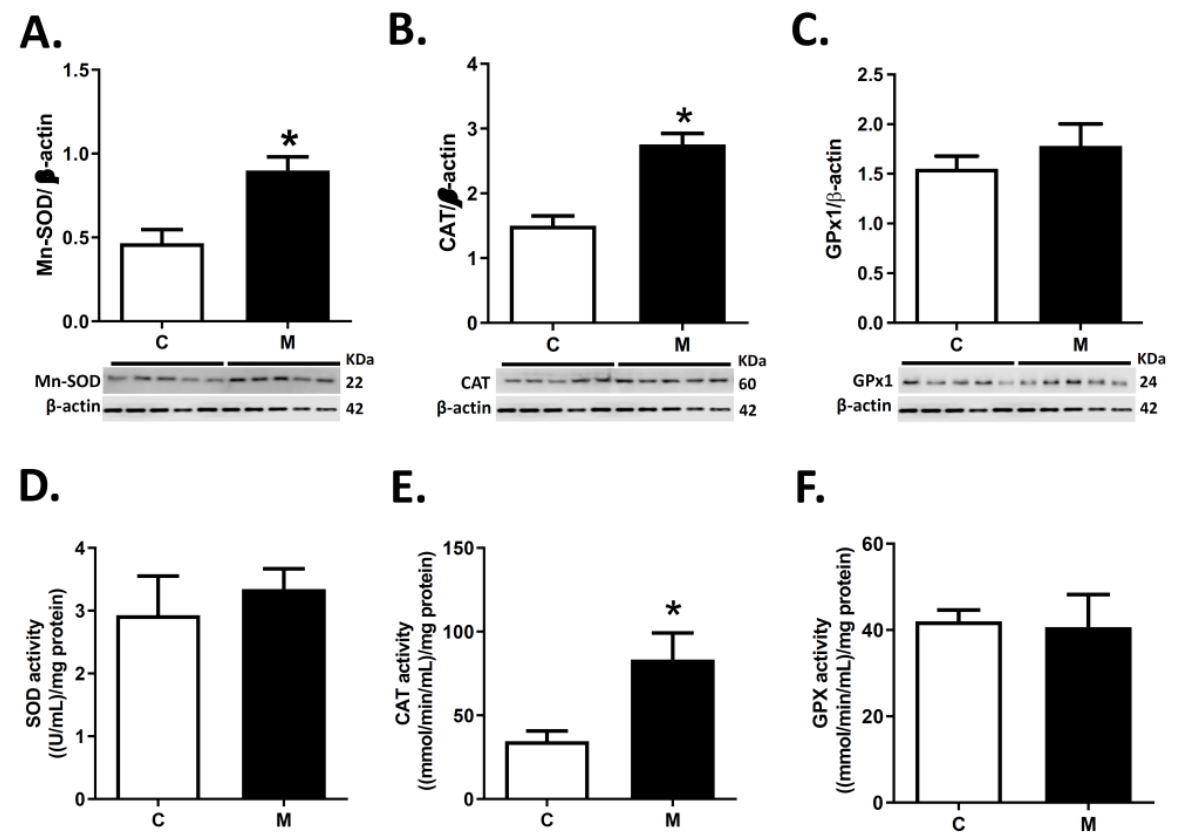
Figure 3. Enzymatic antioxidant expression and activity in right ventricle. Superoxide dismutase (SOD, ( A )), Catalase (CAT, ( B )) and Glutathione peroxidase (GPX, ( C )) expression; and SOD ( D ), CAT ( E ) and GPX ( F ) activities, in right ventricle at 29 days old. Groups are control (C, white bars) and melatonin treated (M, black bars) lambs. Data expressed as mean ± S.E.M. Significant differences ( p ≤ 0.05): * vs. CN.